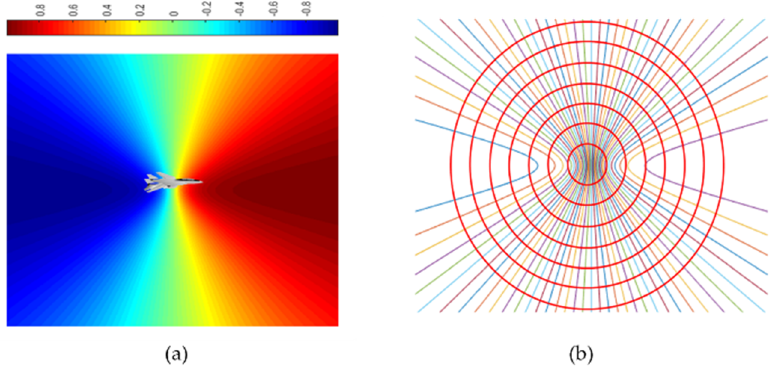
Figure 1. ( a ) Clutter isodops and ( b ) range rings overlaid on clutter isodops.